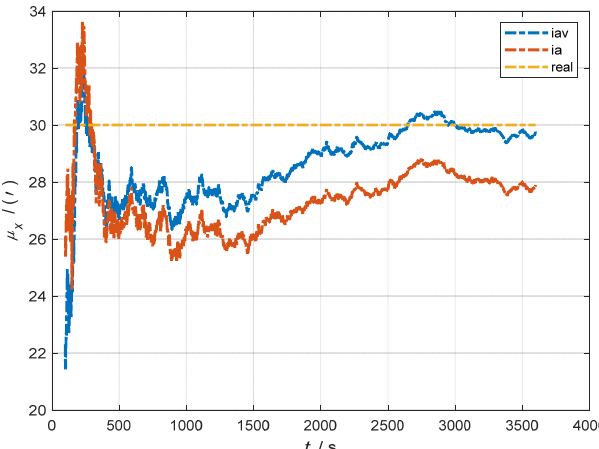
Sensors 2022 , 22 , x FOR PEER REVIEW Figure 19. The curves of µ x in the cases of the initial misalignment angles [ 5 ◦ 5 ◦ 20 ◦ ] T .